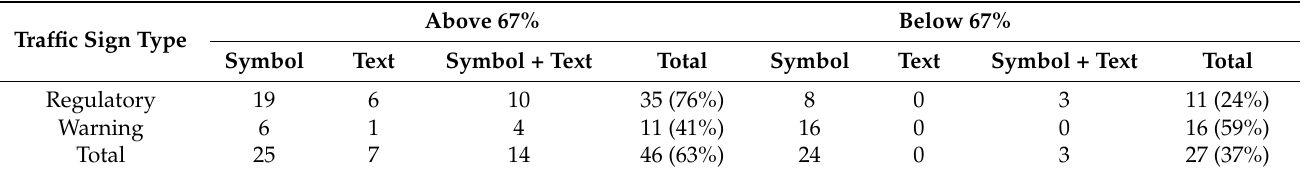
Table 3. The evaluation result of the traffic signs based on the 67% passing rate set by 1SO